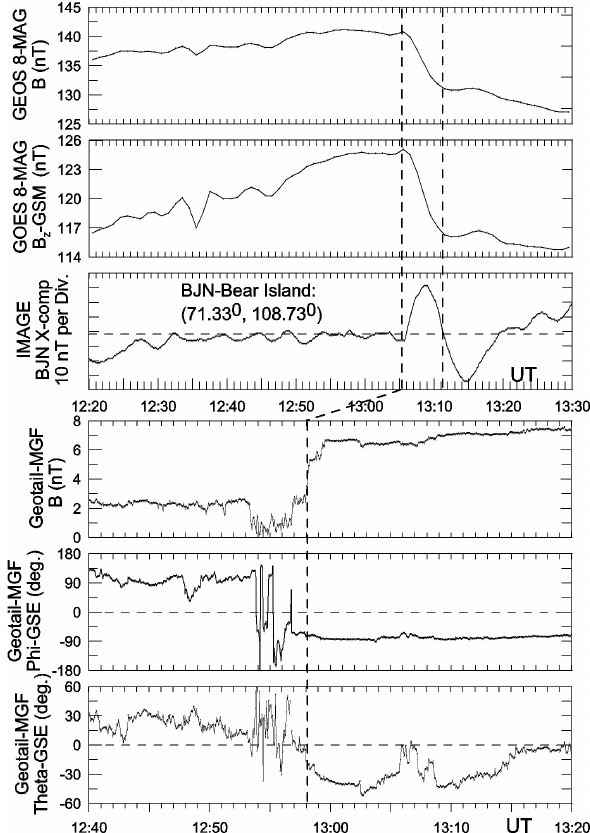
Fig. 13. The geosynchronous GEOS 8 satellite magnetic field mag- nitude, and B z component, measurements concurrently with the BJN station X-component trace (three top panels). The steep de- crease in B z is associated with the PN-type feature in BJN sta- tion. Additionally, vector magnetic field measurements (strength, azimuthal and polar angles) obtained by Geotail are shown in the bottom three panels. The dashed line defines the time of solar wind pressure